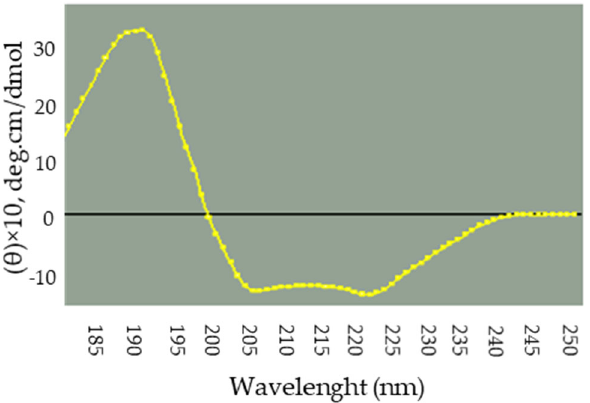
Figure 3. Secondary structure content of LBP, indicating the richness of α -helical content.